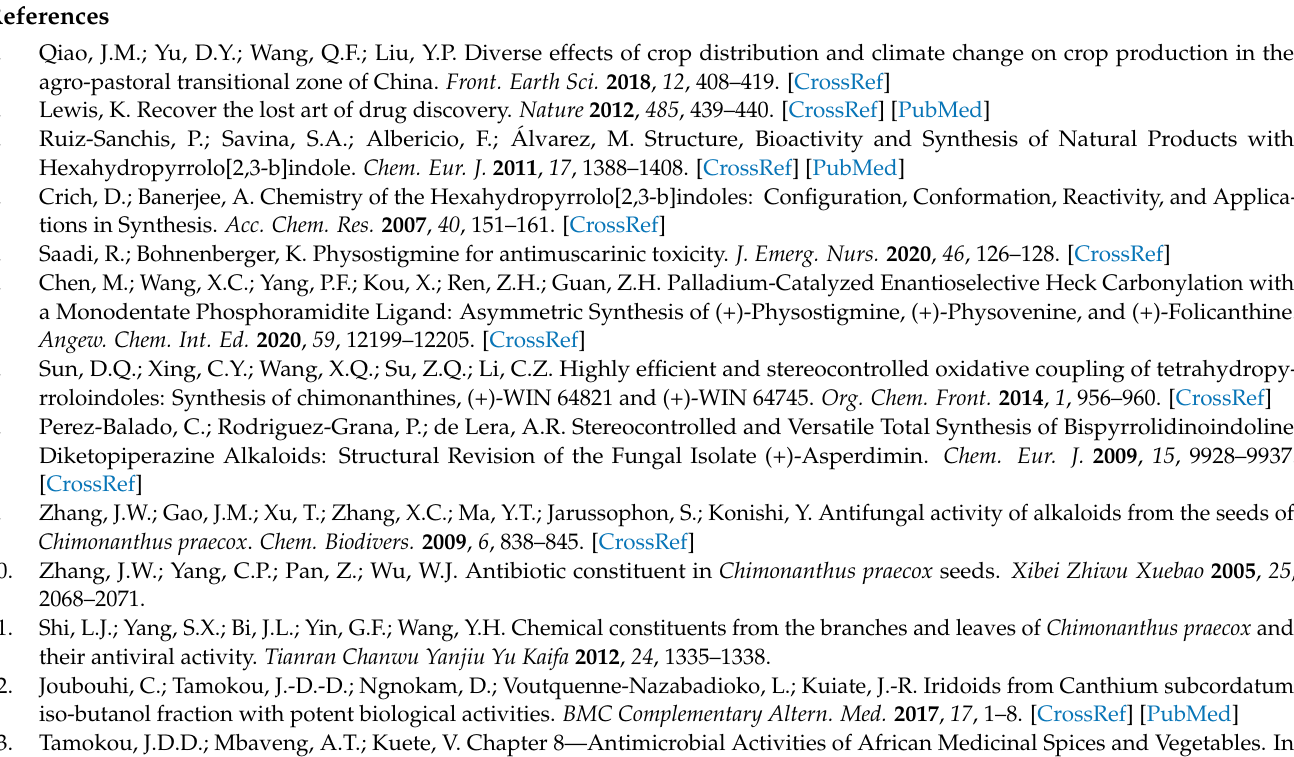
of compound b8 ; Figure S57: 1H-NMR spectroscopic data of compound b9 ; Figure S58: 13C-NMR spectroscopic data of compound b9 ; Figure S59: 1H-NMR spectroscopic data of compound b10 ; Figure S60: 13C-NMR spectroscopic data of compound b10 ; Figure S61: 1H-NMR spectroscopic data of compound b11 ; Figure S62: 13C-NMR spectroscopic data of compound b11 ; Figure S63: 1H-NMR spectroscopic data of compound b12 ; Figure S64: 13C-NMR spectroscopic data of compound b12 ; Figure S65: 1H-NMR spectroscopic data of compound b13 ; Figure S66: 13C-NMR spectroscopic data of compound b13 ; Figure S67: 1H-NMR spectroscopic data of compound b14 ; Figure S68: 13C-NMR spectroscopic data of compound b14 ; Figure S69: 1H-NMR spectroscopic data of compound b15 ; Figure S70: 13C-NMR spectroscopic data of compound b15 ; Figure S71: 1H-NMR spectroscopic data of compound b16 ; Figure S72: 13C-NMR spectroscopic data of compound b16 ; Figure S73: 1H-NMR spectroscopic data of compound b17 ; Figure S74: 13C-NMR spectroscopic data of compound b17 ; Figure S75: 1H-NMR spectroscopic data of compound b18 ; Figure S76: 13C-NMR spectroscopic data of compound b18 ; Figure S77: 1H-NMR spectroscopic data of compound b19 ; Figure S78: 13C-NMR spectroscopic data of compound b19